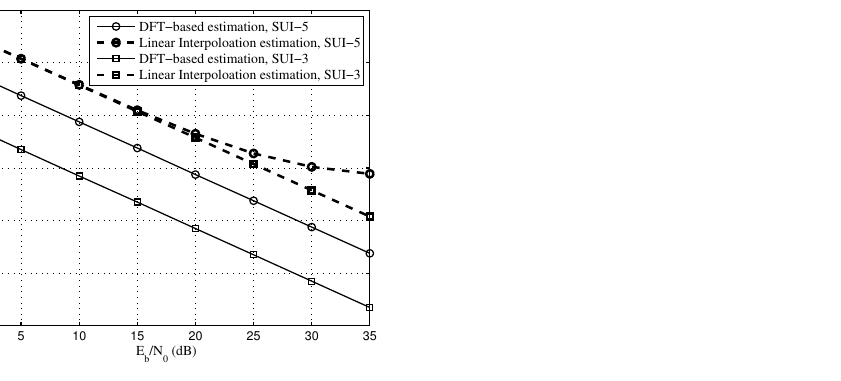
Figure 11. MSE of the proposed DFT-based and linear interpolation methods, time synchronization error L e = 0.9 µ s.